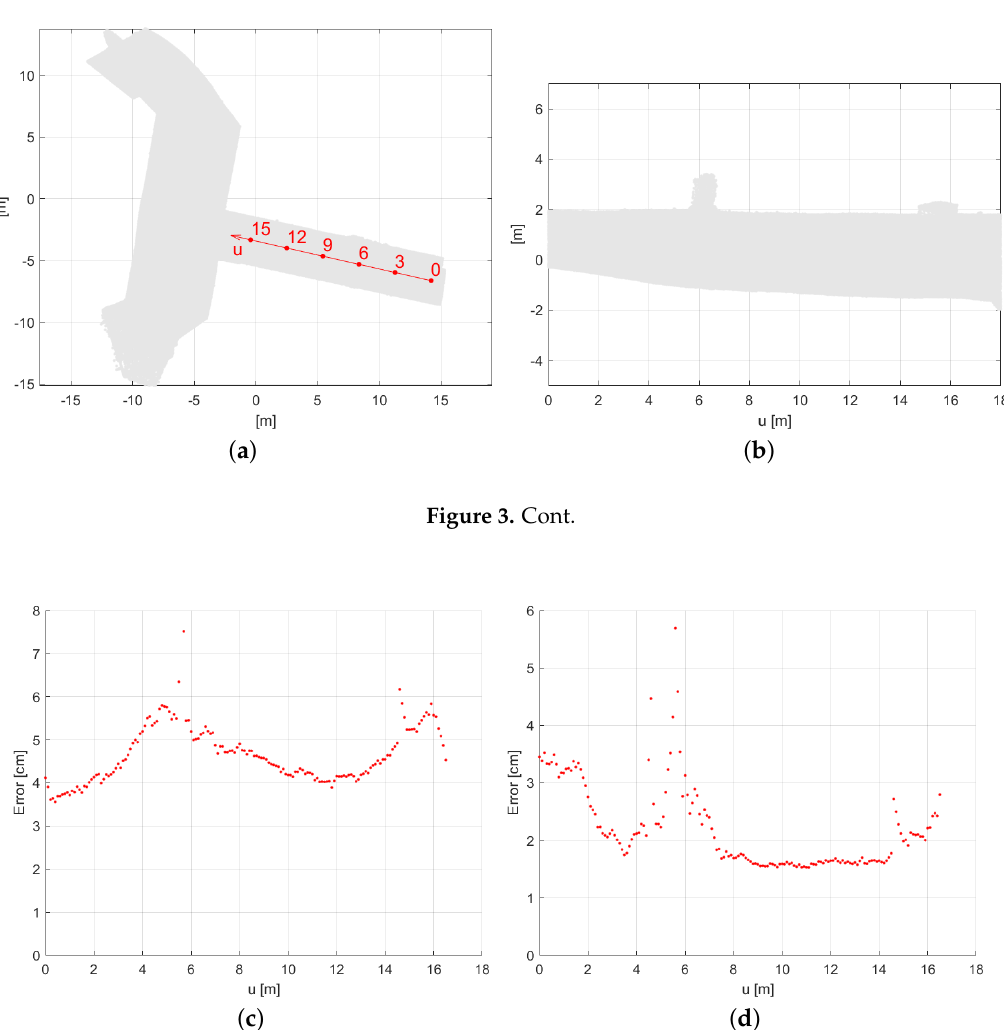
Figure 3. Leica Pegasus precision assessment: comparison of two 3D models generated in successive surveys. ( a ) Top view of the Pegasus backpack 3D model and line u (in red) corresponding to the corridor direction. ( b ) Profile view of the corridor of the Pegasus backpack 3D model. ( c ) Average error between the two 3D models evaluated on slices distributed along the line u . ( d ) Average error between the two 3D models after registration with ICP.